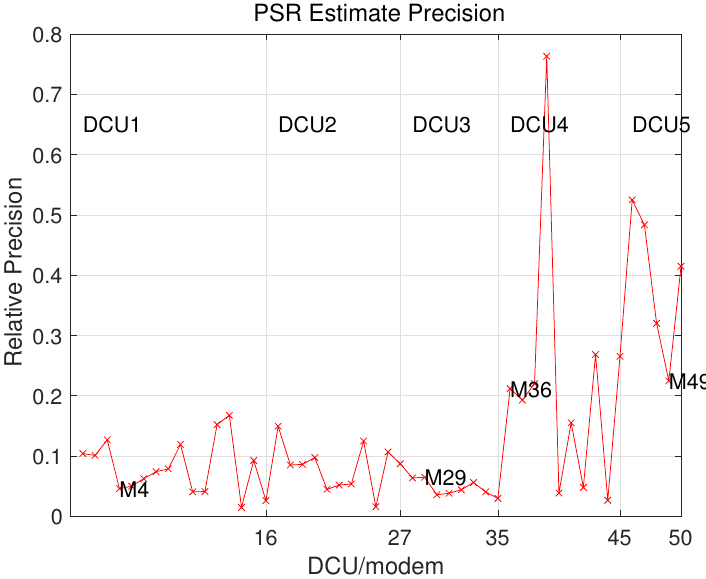
Figure 13. Relative precision of the PSR estimate for Daejeon TS. Estimate designed using the 20 BPS features as Figure